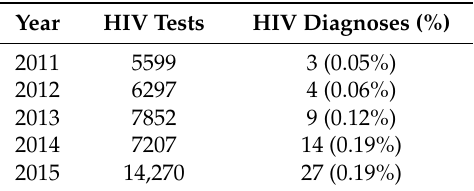
Table 1. HIV (Human Immunodeficiency Virus) testing in study hospital over five